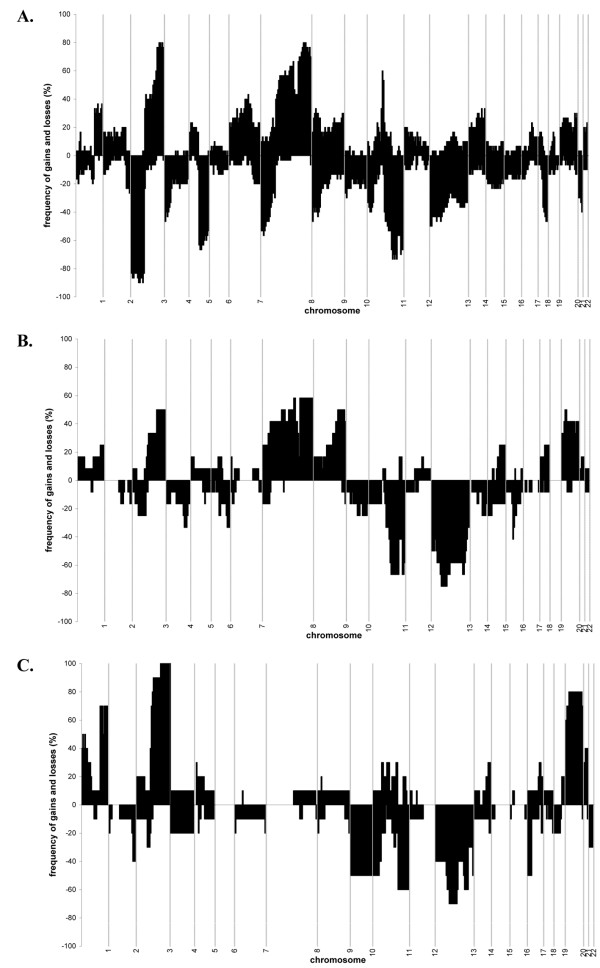
Frequency plots for all 3 sample groups. The frequency of gains (positive axis) and losses (negative axis) are shown for A. hrHPV-negative HNSCCs, B. hrHPV-positive HNSCCs and C. CxSCCs for chromosome 1–22.